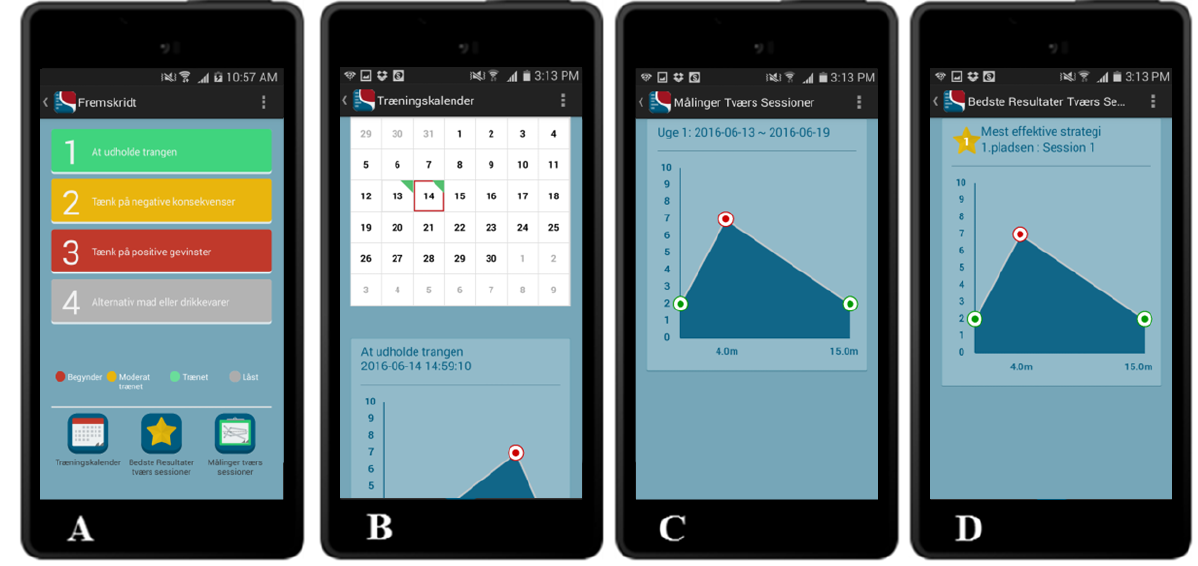
Figure 6. My progress (part A), calendar (part B), best results across strategies (part C), and measures across strategies (part D).